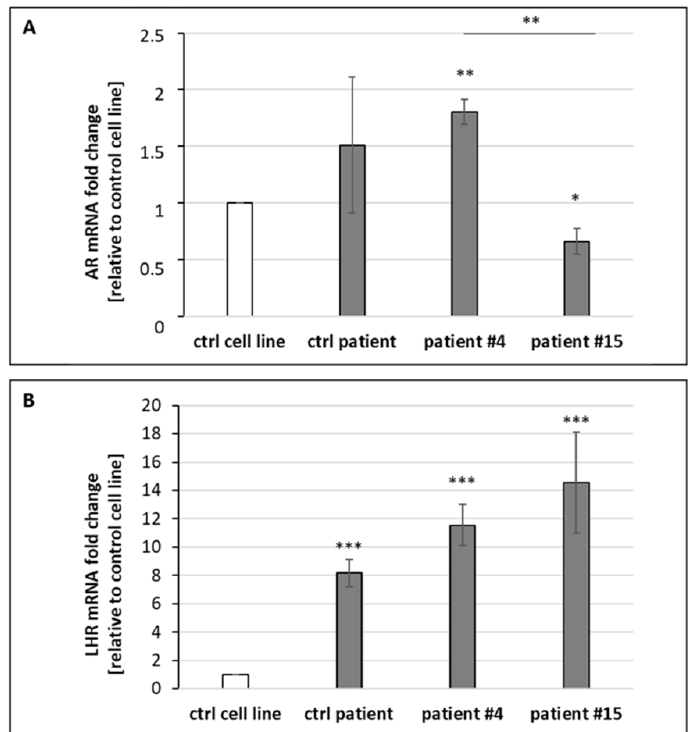
Figure 2. mRNA expression levels of AR and LHR in gubernacular cells. Analysis of mRNA expression levels of ( A ) AR and ( B ) LHR in gubernacular cells cultured in vitro. Receptor mRNA levels were normalized on the housekeeping gene ( RPLP0 ) expression and reported as fold change relative to the breast cancer cell line MCF7. PaCa44 cell line, used as a negative control, was not reported in the analysis because, in these cells, the expression of the two receptors was absent (undetermined). Gubernacular cells derived from a 2-year-old patient affected by cryptorchidism were used as a control (control “ctrl” patient). Values are the means ( ± SD) of two independent biological replicates. Statistical legend: p < 0.05 (*), p < 0.01 (**), and p < 0.001 (***) for gubernacular cells versus control cells (MCF7) or for patient #4 versus patient #15.